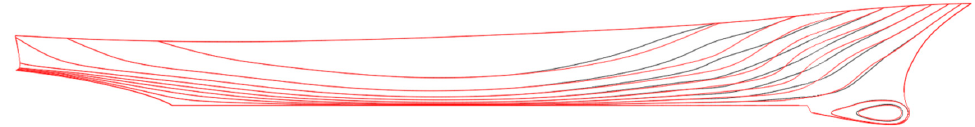
Figure 23. Comparison of body plan views of hull forms obtained by direct and dimensionality reduction optimizations.